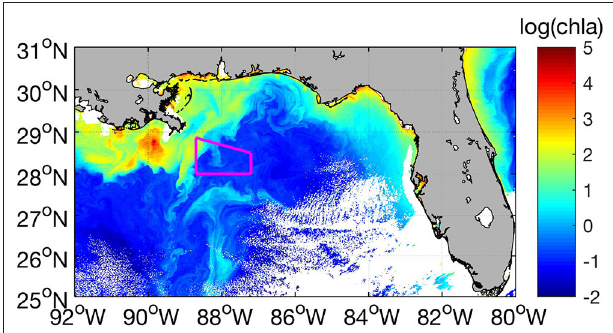
FIGURE 2 | The Gulf of Mexico with the STARSS area of operation, as established by agreement with the Federal Aviation Administration and Gulf Coast Helicopter operators, outlined in magenta. A MODIS Aqua chlorophyll- a image that was acquired on 10 February 2016 reveals a feature-rich submesoscale environment in the area of